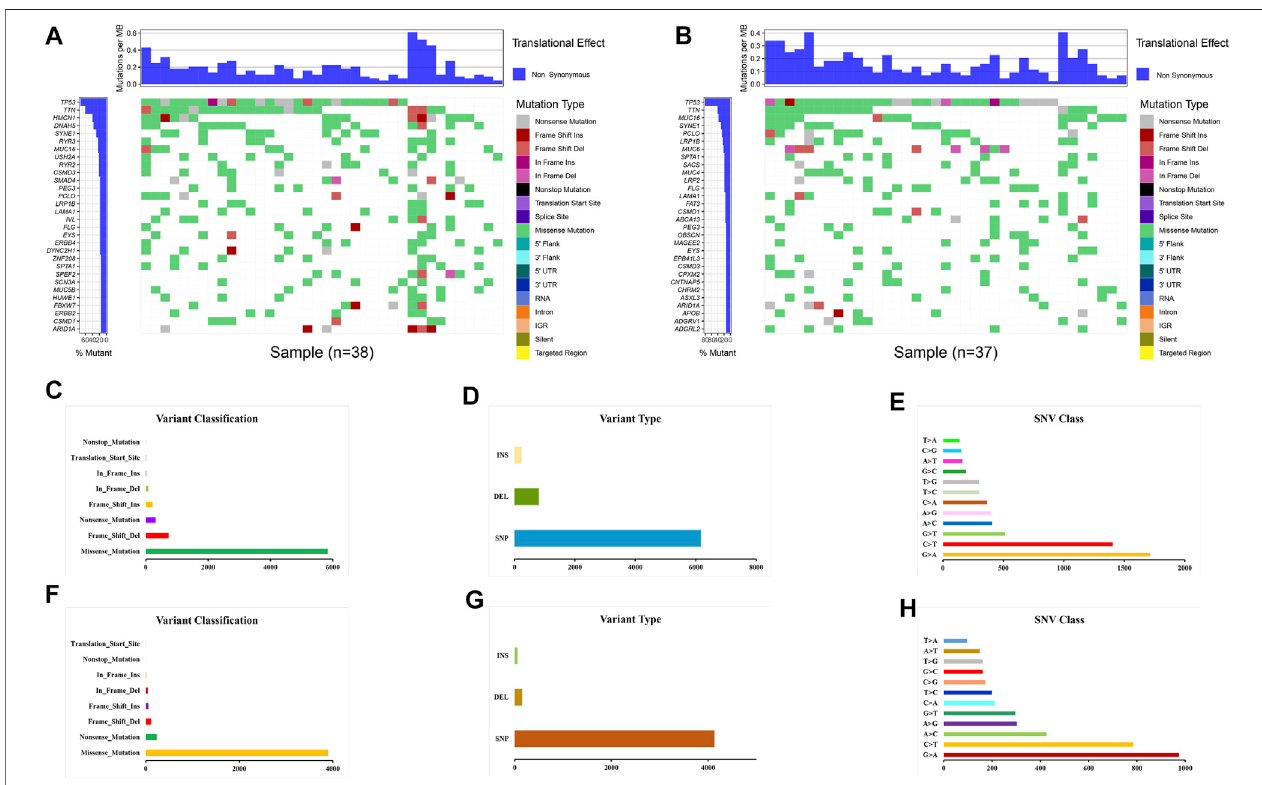
FIGURE6| Landscapeofgenemutations inEAC patients. (A) Waterfall plotofmutationalgenesintheESTIMATE high group. (B) Waterfall plotofmutationalgenes in the ESTIMATE low group. The left panel shows the gene mutational frequencies, and the right panel represents the mutational type. (C) Variant classi fi cation and frequency of gene mutations in the ESTIMATE high group. (D) Variant type in the ESTIMATE high group. (E) Frequency of SNV classes in the ESTIMATE high group. (F) Variantclassi fi cation and frequency ofgene mutationsin theESTIMATE low group. (G) Varianttypein theESTIMATE low group. (H) Frequency ofSNV classes inthe ESTIMATE low